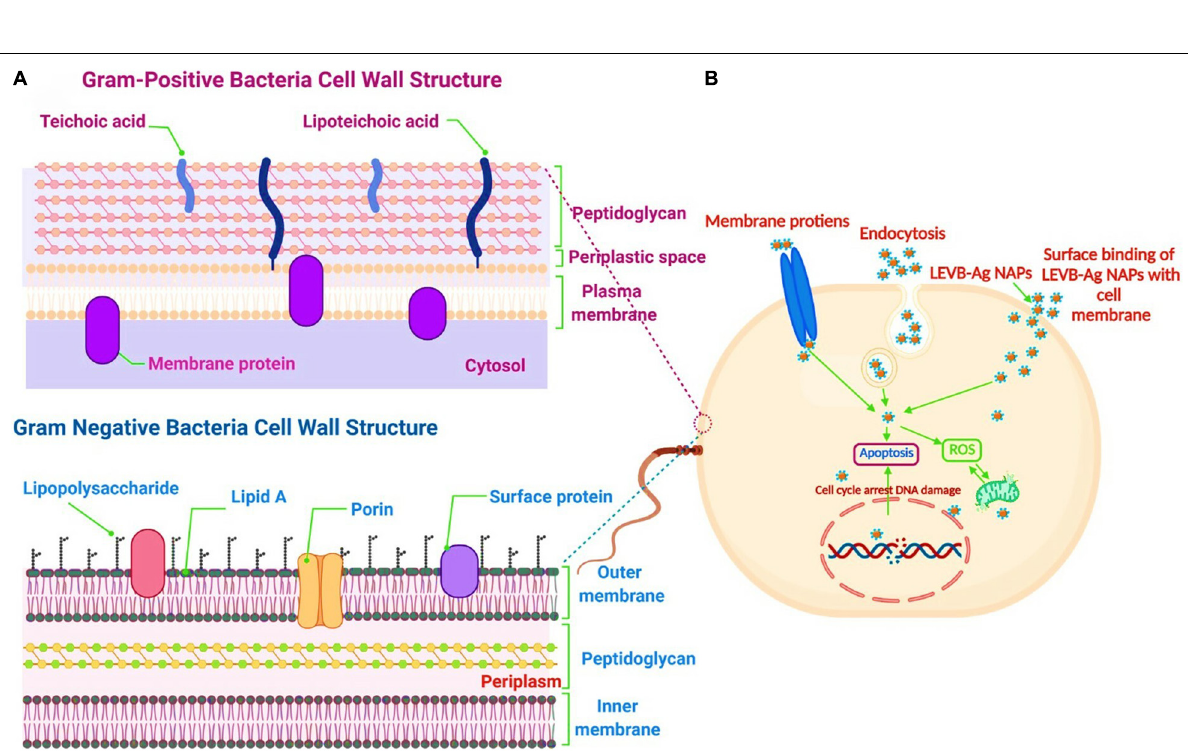
Frontiers in Microbiology |